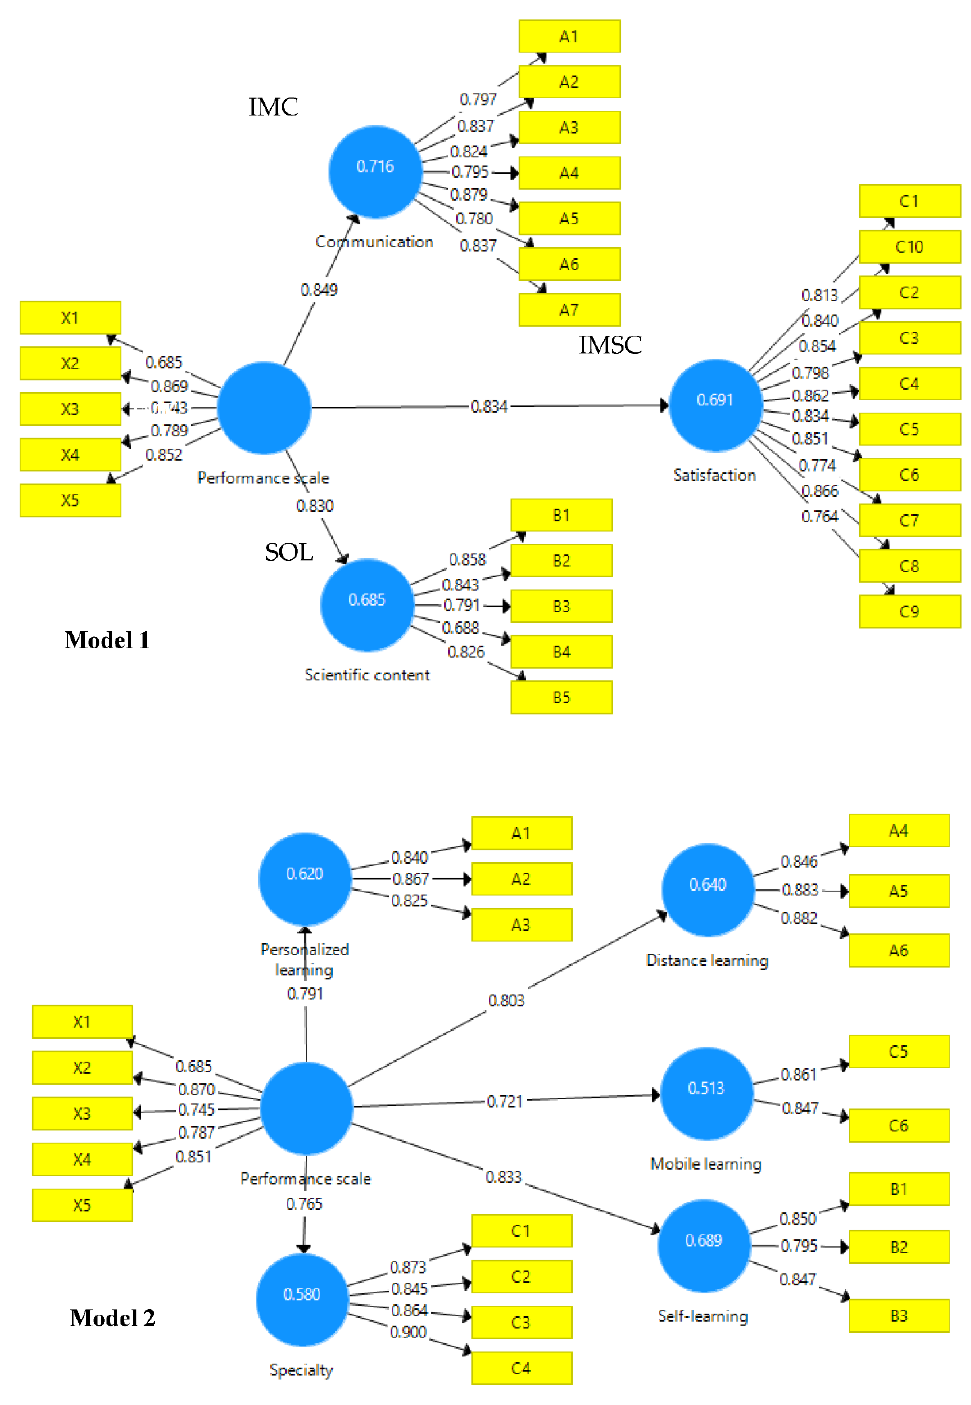
Figure 12. Measurement of the dependent variables for the proposed models 1 and 2. Note: IME = improving evaluation; IMC = improving communication; IMSC = improving scientific; SOL = satisfaction of learning. Table 10. Structural models for hypothesis testing results.